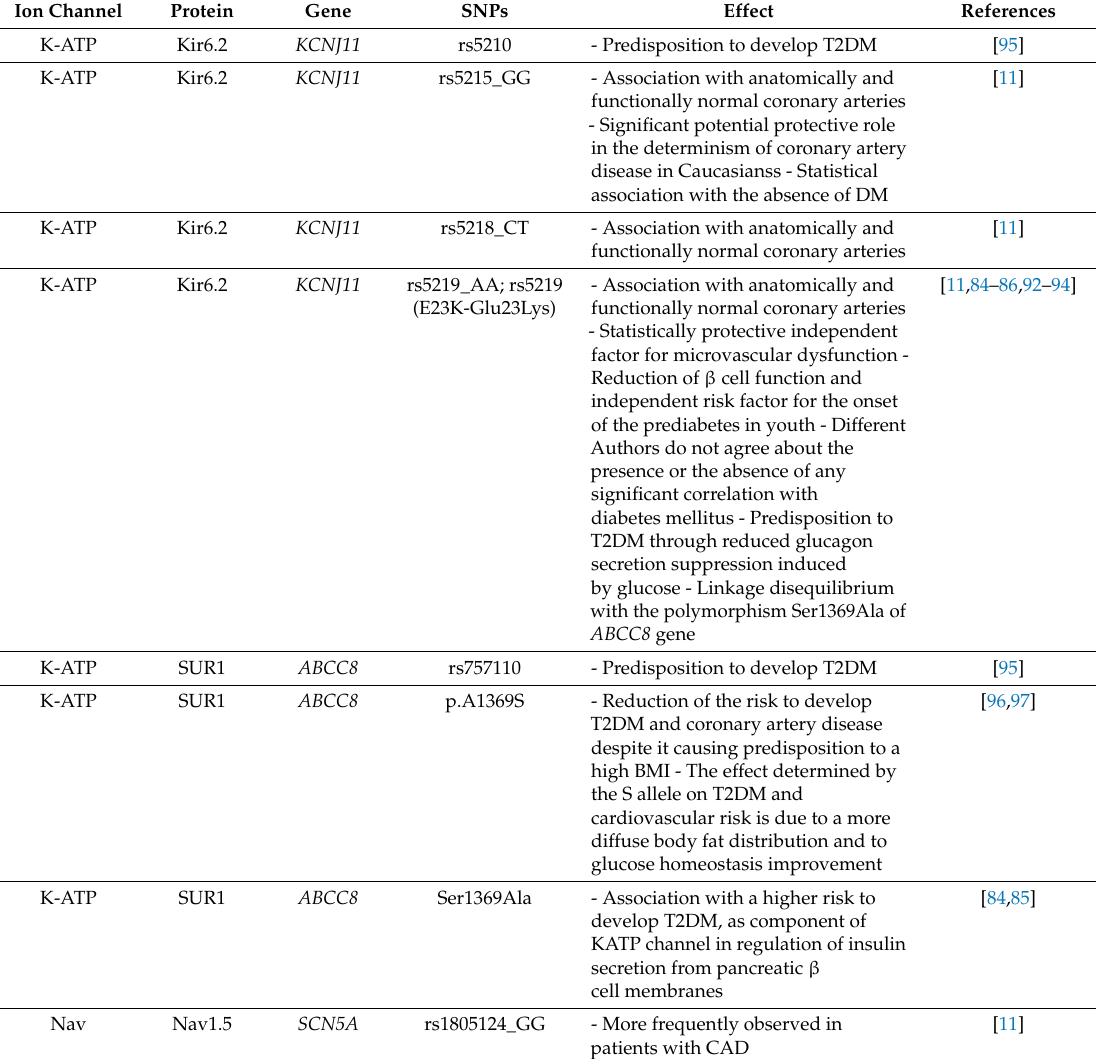
Table 2. List of single-nucleotide polymorphisms of genes encoding for different ion channels and their correlation with ischemic heart